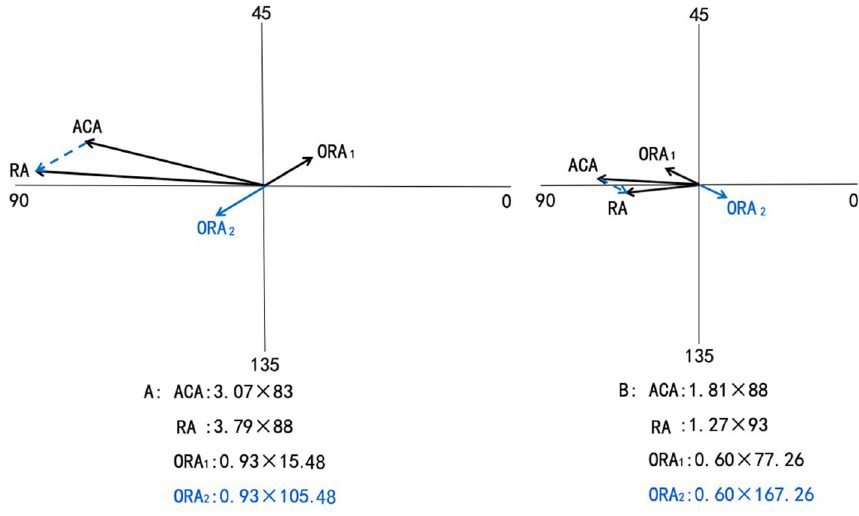
Figure 1. The calculation process of ORA. ORA 1 : The erroneous ORA. ORA 2 : The actual ORA.